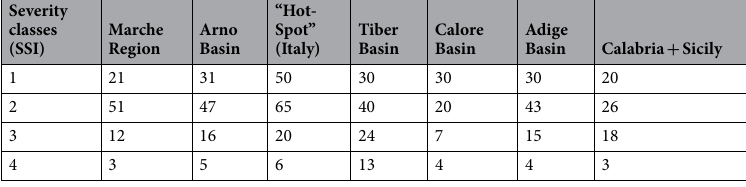
Table 1. Number of storm severity index (SSI) classes for each geographical